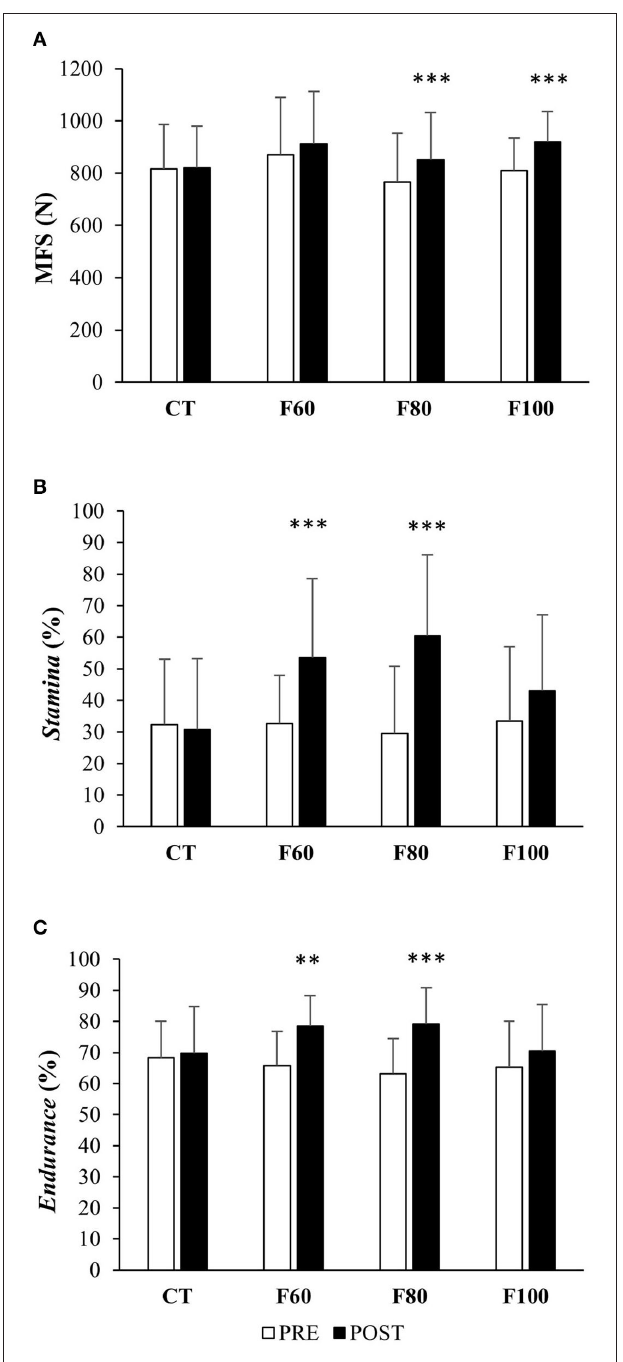
FIGURE 3 | Mean values ( ± standard types) of (A) maximal finger strength (MFS in N), (B) stamina (in %), and (C) endurance level (in %) in each group (CT, F60, F80, and F100) pre- (white bars) and post- (black bars) training. Significance differences were shown (** p < 0.01 and *** p < 0.001) relative to pre-training.